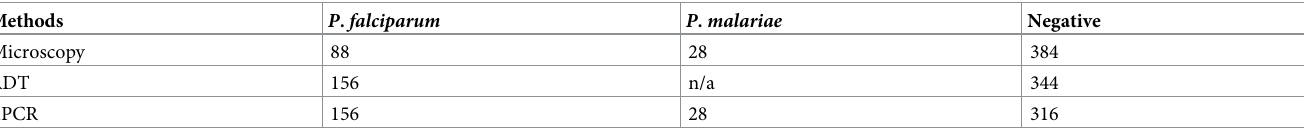
Table 4. Comparison of microscopy and RDT with nPCR for the detection of asymptomatic malaria